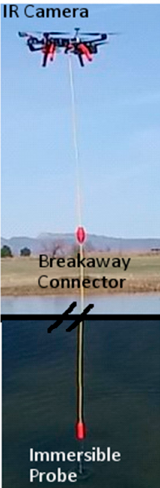
Figure 3. Photograph of the flying UAS in its final flight configuration with all sensors and the umbilical cord. (Full length of the cord is not shown).